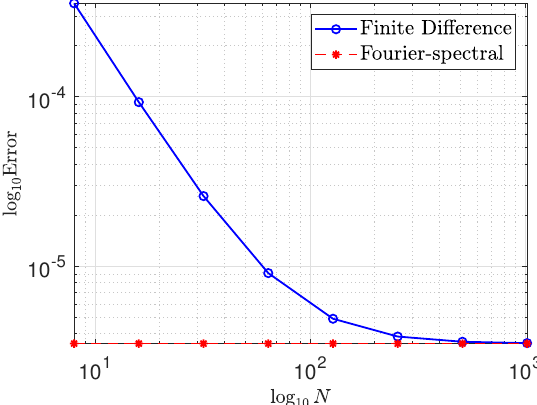
Figure 2. Convergence of second-order finite difference and Fourier-spectral method with backward difference in time to Equation (1) . Note that both axes are on log-scale and ∆ t =